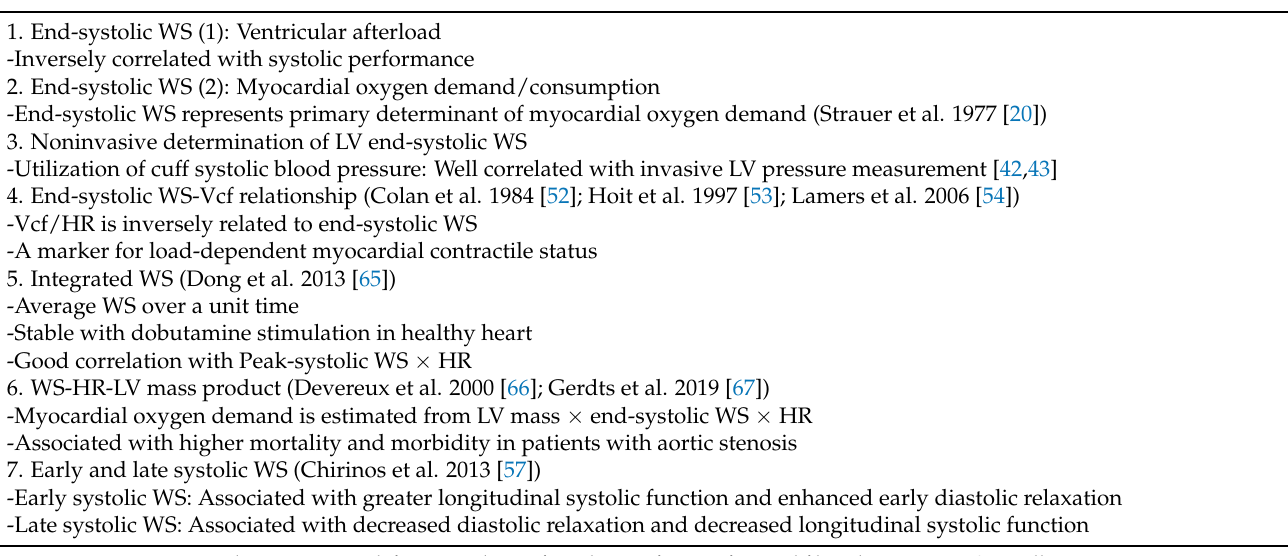
Table 1. Clinical Applications of Systolic Wall Stress (WS) in